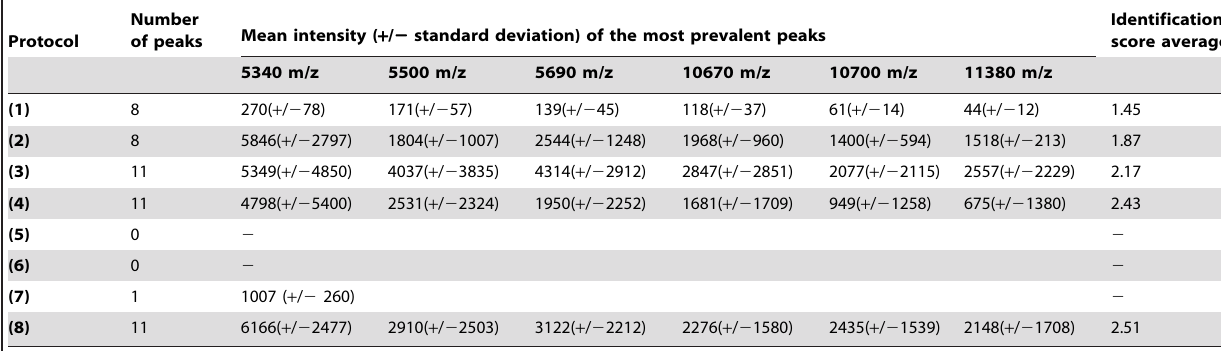
Table 3. Spectra obtained from Mycobacterium tuberculosis H37Rv using the tested protocols.